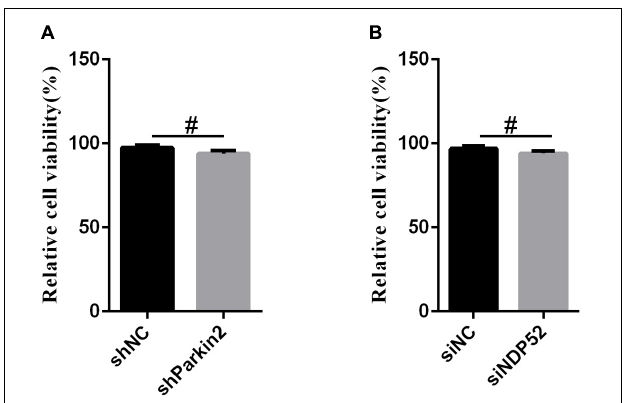
FIGURE 7 | The effect of RNA interference on cell viability. The cell viability of PK-15 cells transfected with scrambled or Parkin shRNA (A) and siNC or NDP52 siRNA (B) was analyzed using the CCK8 assay as described in section “Materials and Methods” (mean ± SD; n = 3; ∗ P < 0.05; ∗∗ P < 0.01; ∗∗∗ P < 0.001; # P >